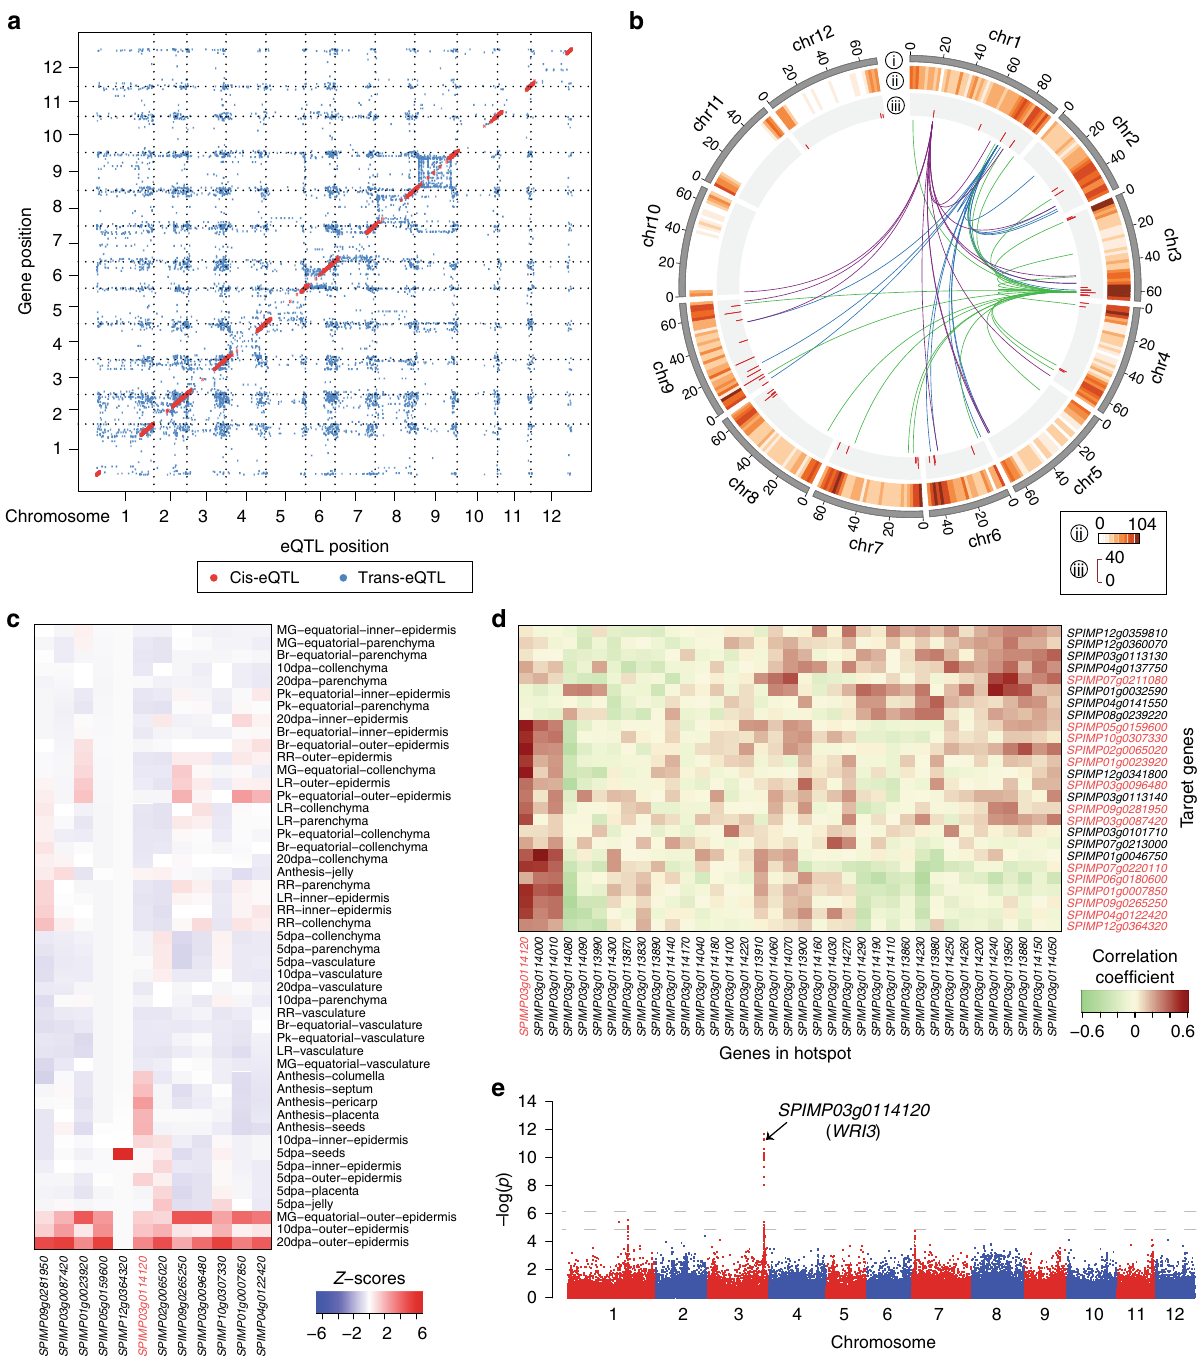
Fig. 4 Genome-wide mapping of eQTLs. a Positions of eQTLs identi fi ed in the genome. b Trans-eQTL hotspots. The outermost circle displays ideograms of the 12 tomato chromosomes. The second circle shows the number of target genes for all eQTLs in each 2-Mb window. The third circle shows the number of target genes of each trans-eQTL hotspot. The innermost circle shows the links between three interesting eQTL hotspots and their target genes. Links between the three hotspots harboring the master regulators, A20/AN1 zinc fi nger protein, MYB12, and WRI3, respectively, and their target genes are depicted in purple, blue and green, respectively. c Expression pro fi les of WRI3-targeted lipid biosynthetic genes in different tomato tissues. The WRI3 gene ( SPIMP03g0114120 ) is highlighted in red. d Correlation coef fi cients between the expression levels of genes in the WRI3 -hotspot and target genes. WRI3 and the target lipid biosynthetic genes are highlighted in red. e Manhattan plot of eQTLs associated with the WRI3 expression. The horizontal dashed lines correspond to the Bonferroni-corrected signi fi cance thresholds at α = 0.05 and α =